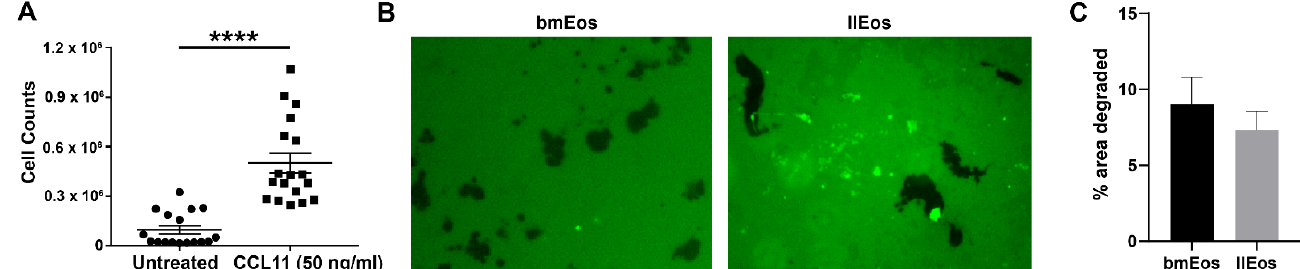
Figure 3. llEos can perform typical eosinophil functions. ( A ) llEos chemotax in response to eotaxin (CCL11). N = 17–19 (combined from three separate experiments). **** p < 0.0001 by unpaired t -test. ( B ) llEos degrade FITC-linked fibrinogen substrates in a similar manner to conventionally cultured bmEos. Green color shows intact FITC-linked fibrinogen. Dark spots depict areas of loss of fibrinogen substrate, visualized using confocal fluorescent microscopy. ( C ) Fibrinogen degradation quantified by pixel areas in ImageJ. Images taken at 20× magnification.